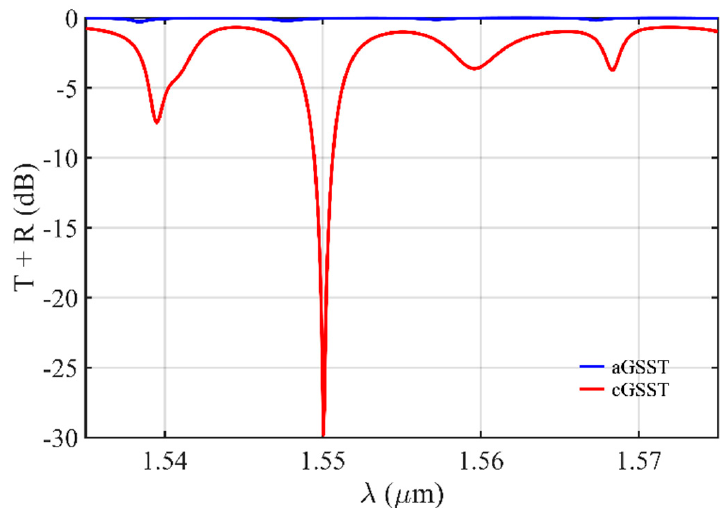
Figure 8. The sum of the transmittance of the output port and the reflectivity of the reflecting port in Sagnac optical buffer based on 1 × 3 MOMRs with GSST.